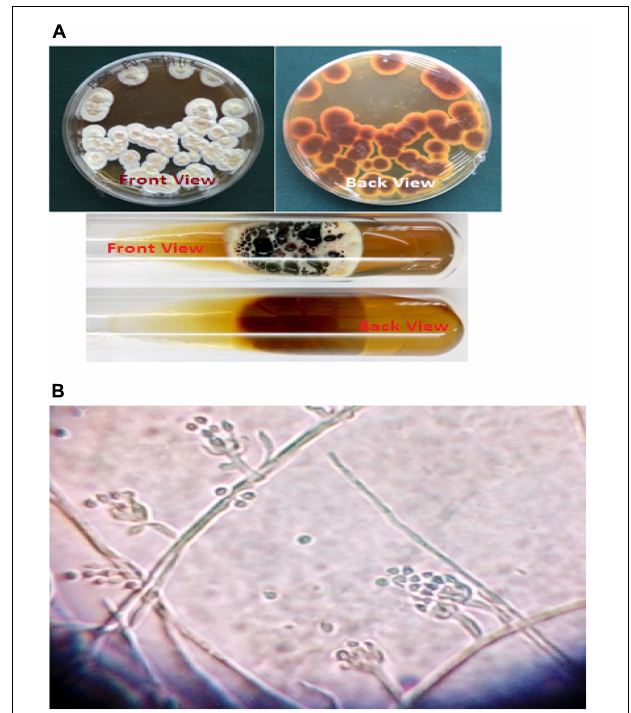
FIGURE 1 | (A) Growth of Paecilomyces variotii on agar plate and tube cultures. (B) Microscopic view of Paecilomyces variotii (15 × 40 × ).